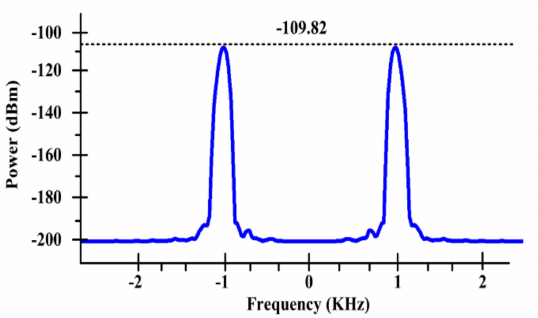
Figure 7. Reconstructed frequency domain signal captured from the 135 MHz ME sensor by the SDR with 61 dB receiver